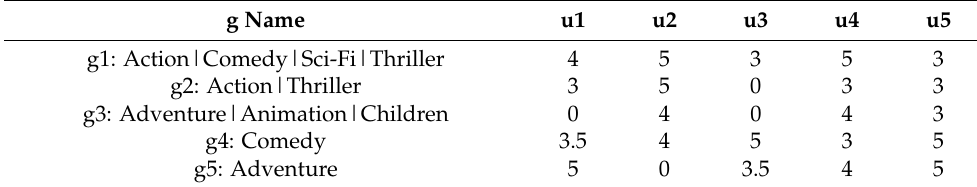
Figure 3. Proposed model flowchart. Table 1. Users (u) and their mean rating on preferred item genres (g).